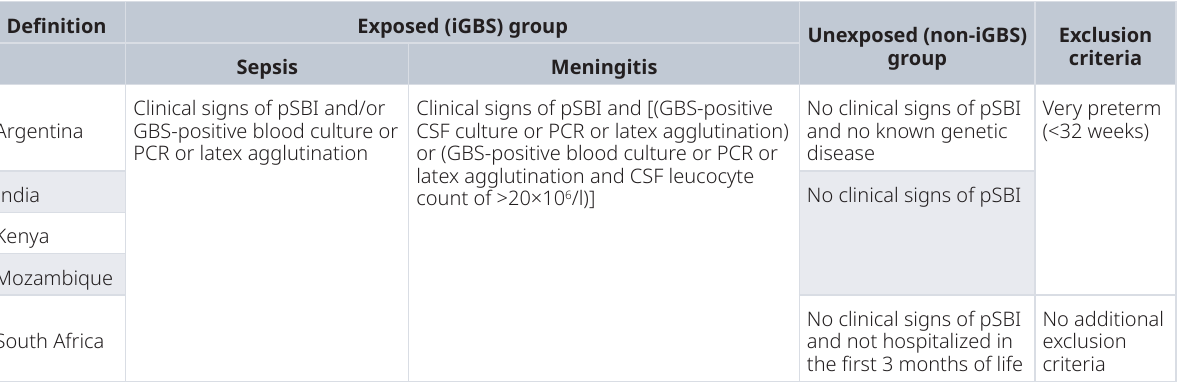
Table 2. Definitions for the exposed (invasive GBS disease) and unexposed (non-iGBS) groups, and exclusion criteria used for recruitment for the long-term outcomes study (adapted from